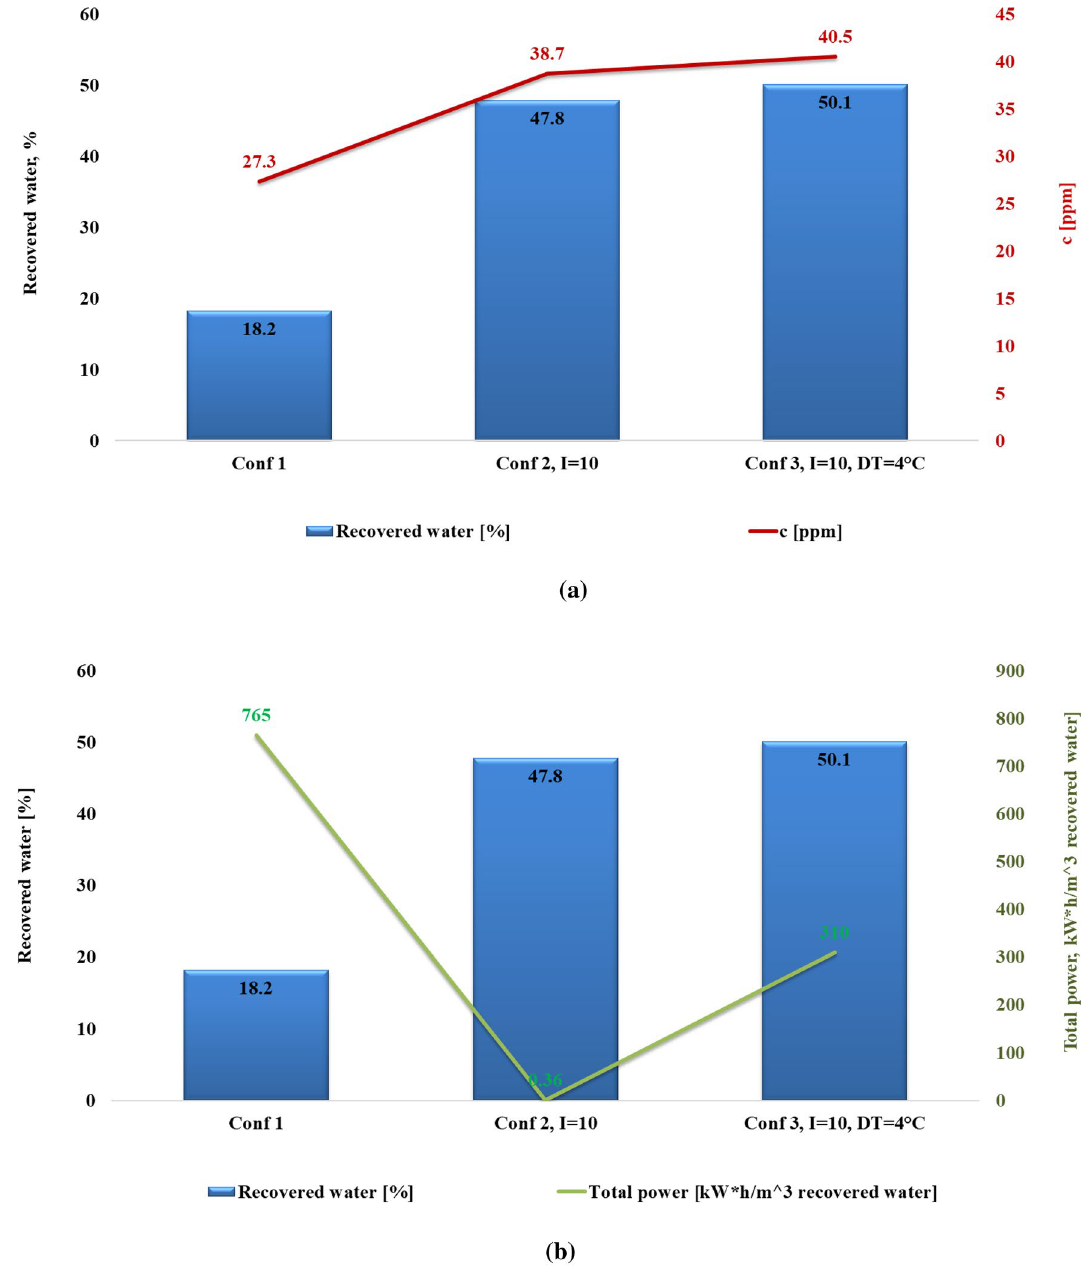
Fig. 13 Comparison among the three different configurations in terms of water recovery and a concentration, b energy